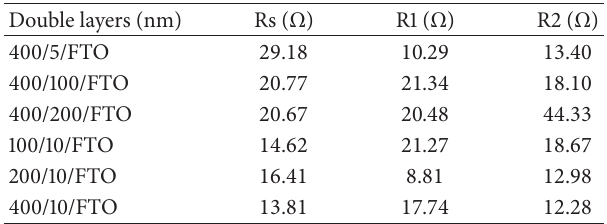
Table 3: The parameters of charge transfer resistance in double- layer structures by EIS